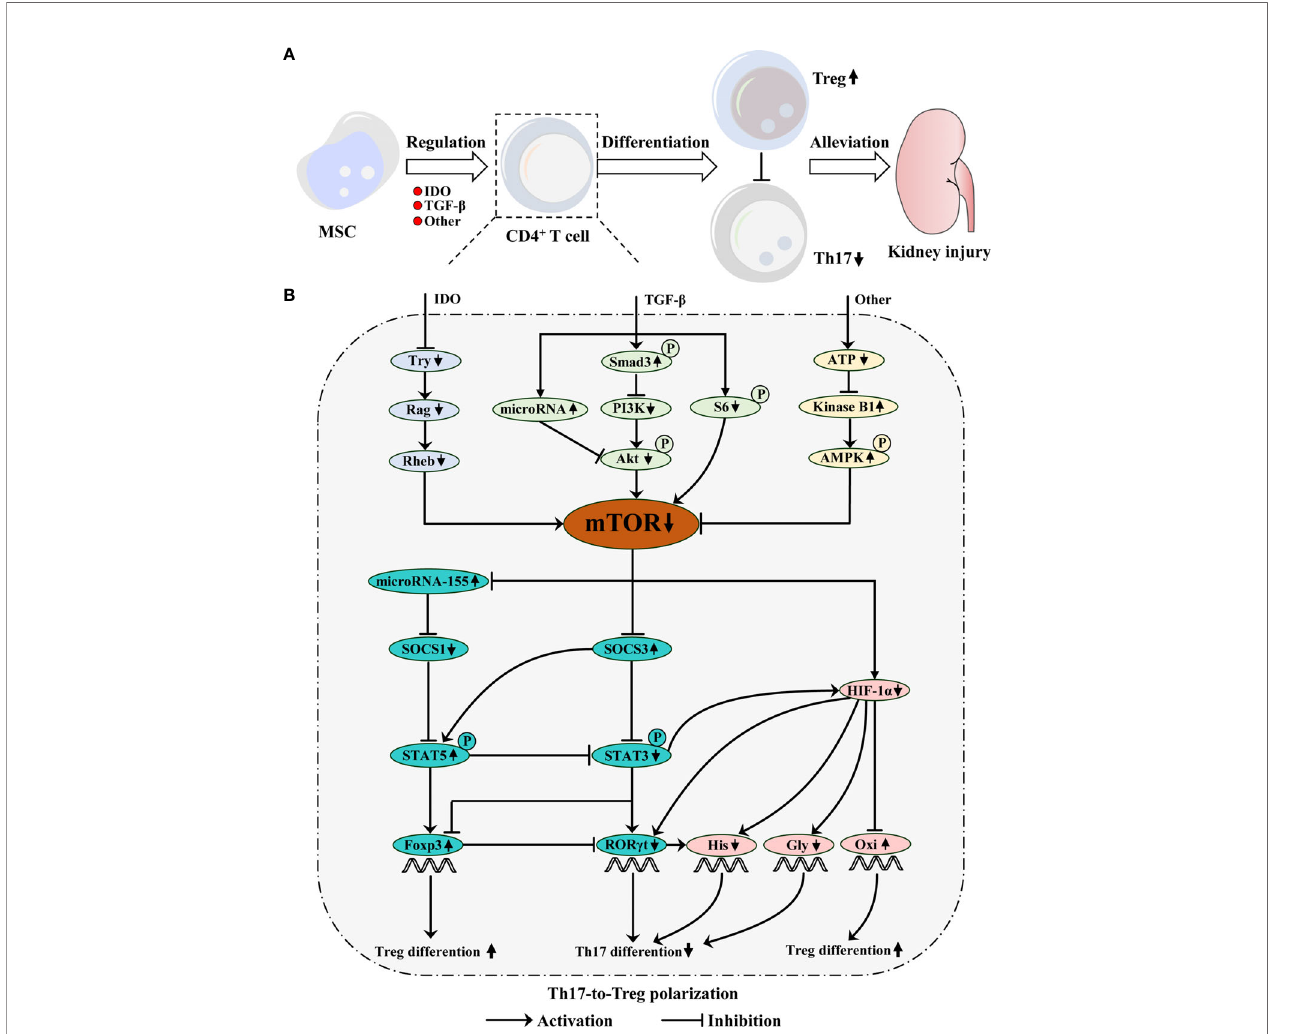
FIGURE 1 | Mesenchymal stem cell (MSC) protects kidney injury via mTOR-mediated Th17-to-Treg polarization. (A) MSC inhibits mTOR signaling during CD4 + T cell differentiation via IDO and TGF- b secretions as well as other mechanisms, which restrains Th17 differentiation, but promotes Treg generation. Consequently, MSC-mediated Th17-to-Treg polarization alleviates kidney injury. (B) TGF- b phosphorylates Smad3, which inhibits PI3K/Akt/mTOR pathway. TGF- b also inhibits S6- mediated mTOR signaling. Moreover, TGF- b promotes microRNA expression, which can inhibit Akt/mTOR pathway. IDO can deplete tryptophan (Try), which results in mTOR inhibition mediated by the Rag and following Rheb. Additionally, MSC-mediated low ATP concentration increases kinase B1, subsequently phosphorylates AMPK, ultimately inhibits mTOR signaling. However, mTOR signaling can inhibit microRNA-155 and SOCS3 expression, but promote HIF-1 a generation. Brie fl y, microRNA-155 inhibits SOCS1 expression, which can restrain STAT5 phosphorylation. The phosphorylation of STAT5 not only restrains STAT3 phosphorylation, but also upregulates Foxp3 expression, which promotes Treg differentiation. SOCS3 can promote STAT5 phosphorylation, but inhibit STAT3-mediated HIF-1 a and ROR g t expression, which ultimately reduces Th17 differentiation. Moreover, STAT3 possesses the ability to inhibit Foxp3 expression. HIF-1 a can promote ROR g t expression and increase histone acetylation (His) with ROR g t collaboration, which possesses the ability to induce Th17 differentiation. Meanwhile, HIF-1 a inhibition can promote Treg but not Th17 differentiation by mediating glycolysis (Gly) switching into the oxidative phosphorylation